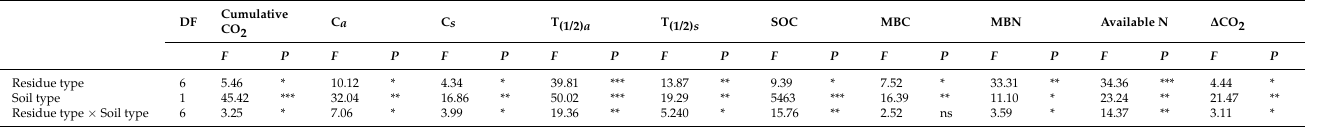
Table 5. Summary statistics of a two-way ANOVA of the residue type and soil type on cumulative CO 2 emission, first order decay model parameters, SOC and other soil biochemical parameters after 61 days of incubation.